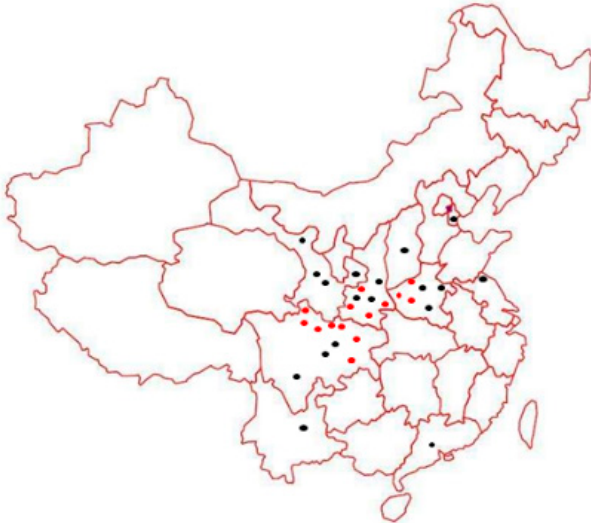
Figure 1. Sites (red dots) for rust sampling of P. deltoides cv. ‘Zhonghua hongye’. Dark dots represent the potential distribution of this formerly rust-free cultivar.